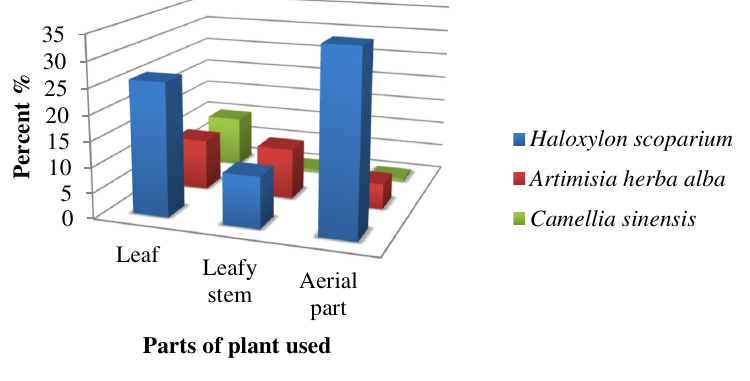
Figure 4. Parts of the plants used